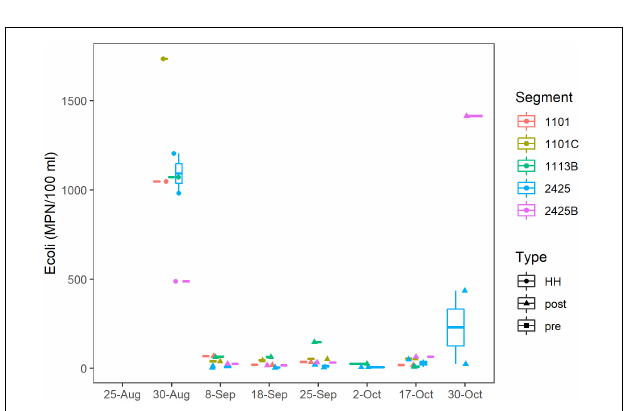
FIGURE 4 | E. coli concentrations over time. MPN/100 ml were assessed by culturing as described in Methods. Dates are as Figure 2A . Figure was generated with scripts in Supplementary File 3 .